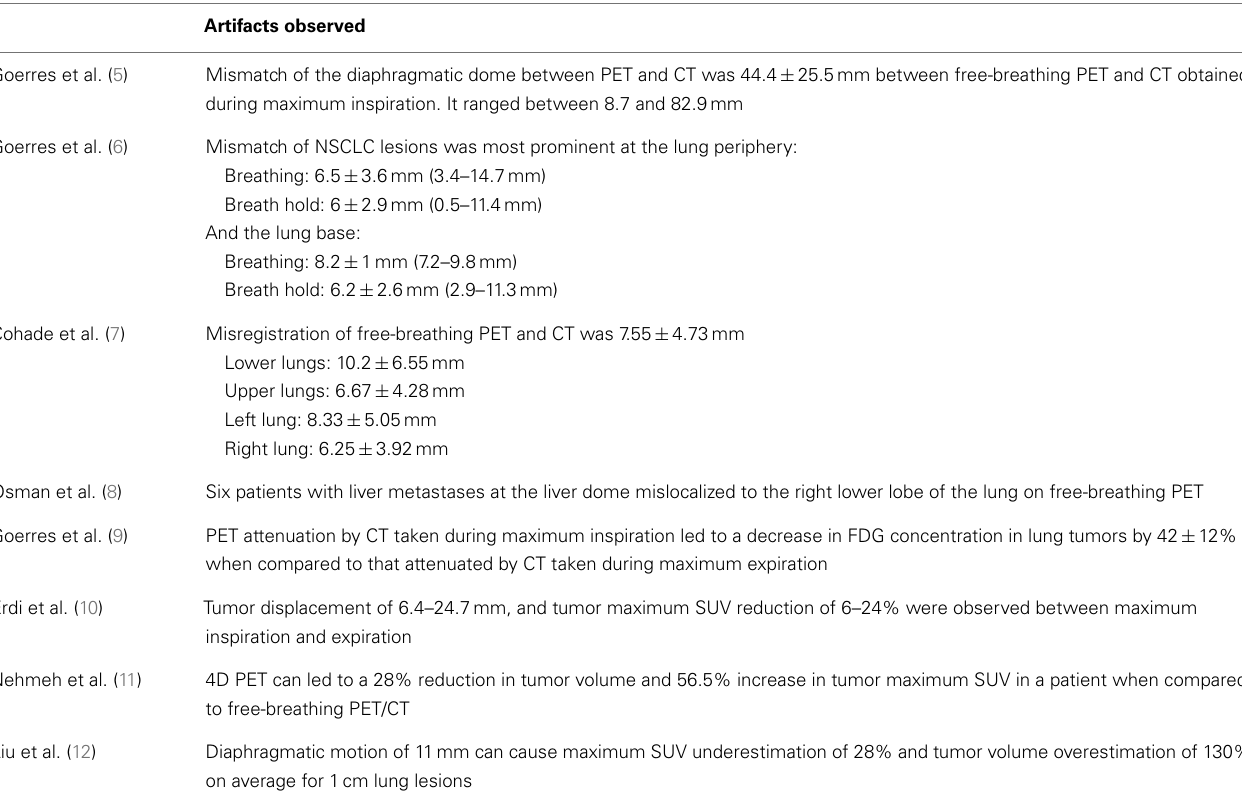
Table 1 | Motion artifacts observed in FDG-PET/CT